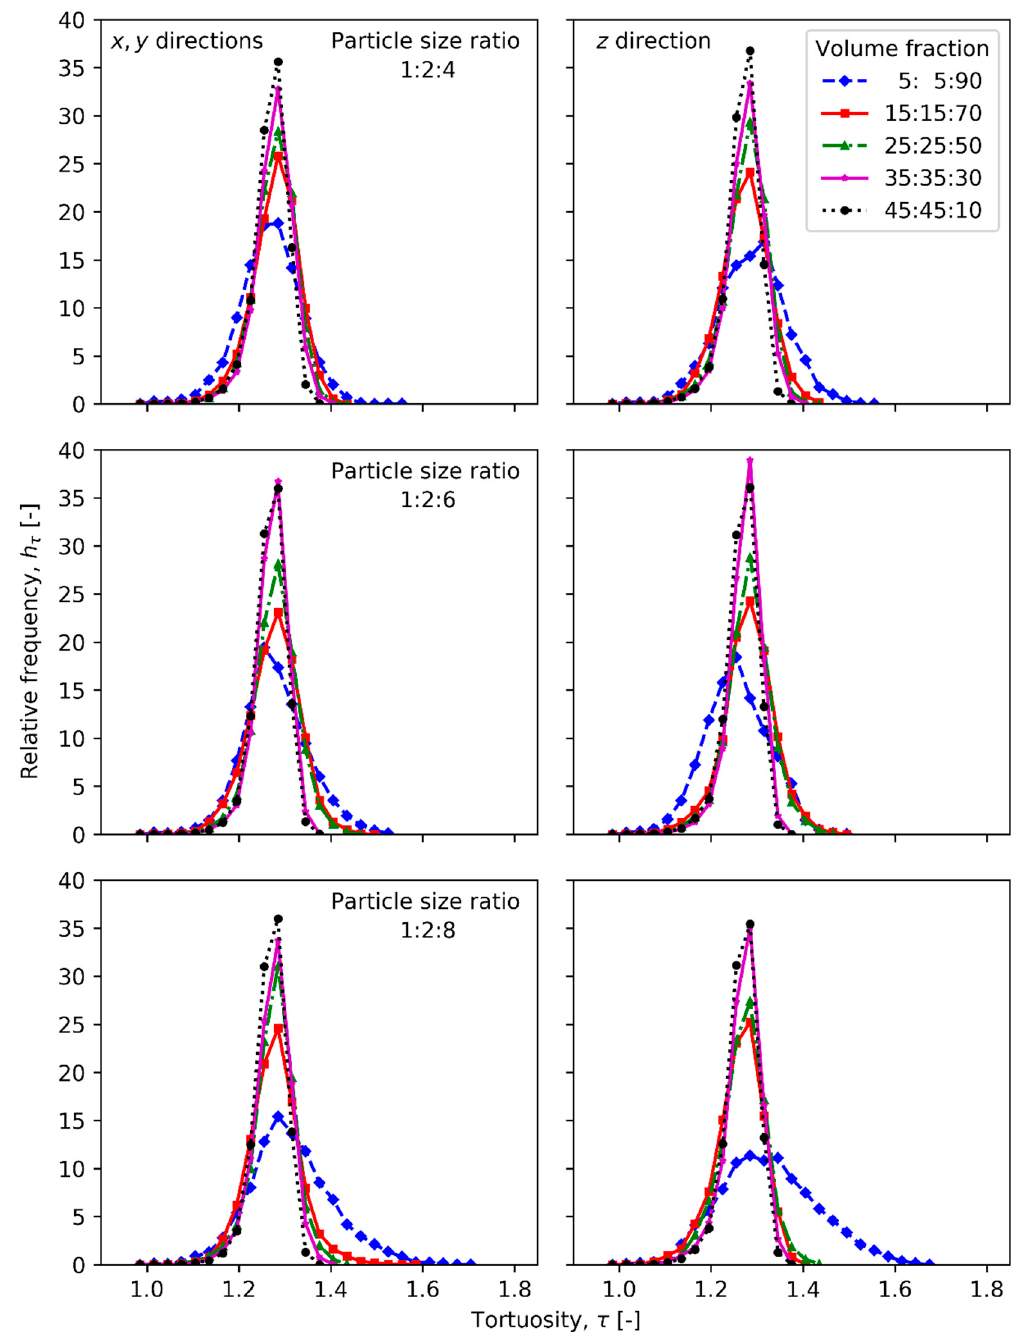
Figure 3. Relative frequency of tortuosity of ternary mixtures having particle size ratio of 1:2:4, 1:2:6 and 1:2:8 with different volume fractions evaluated in x, y and z directions.